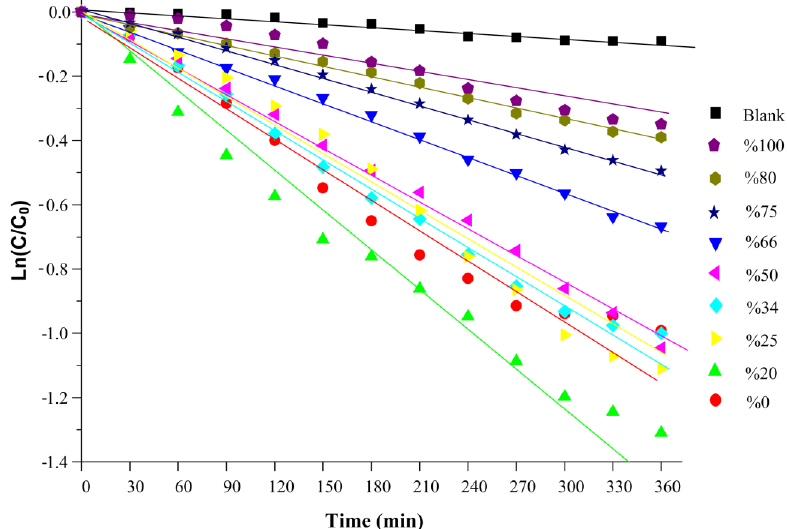
) for the photodegradation of MB in the presence Figure 12. Linear plots of Ln( C / C 0 of physical mixtures of ZnS and CdS with different ZnS weight percentages under visible